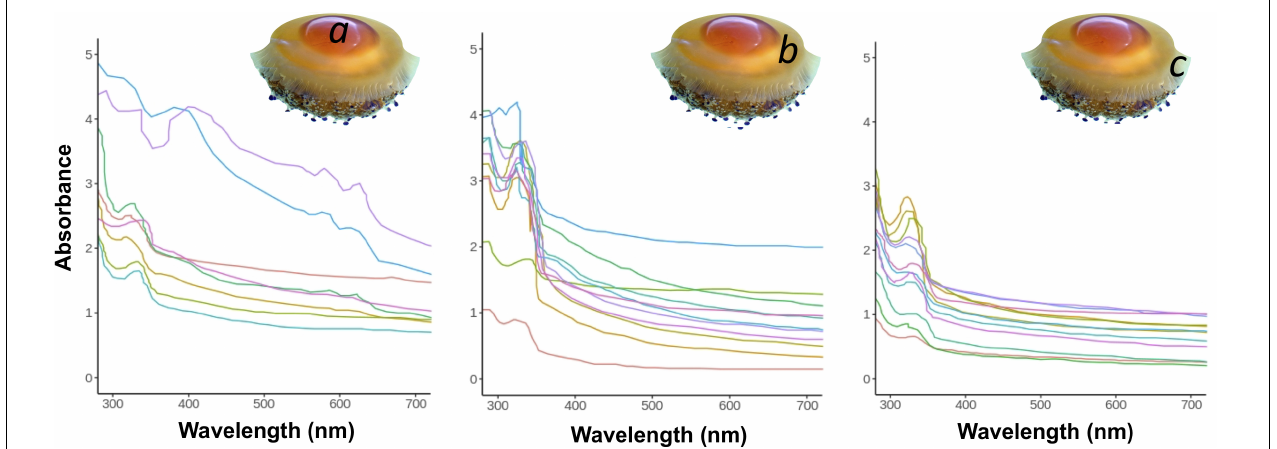
FIGURE 8 | UV-VIS absorption spectra of the three tissue sections of the umbrella of C. tuberculata . (a) Central section, (b) clear section, (c) umbrella edge.